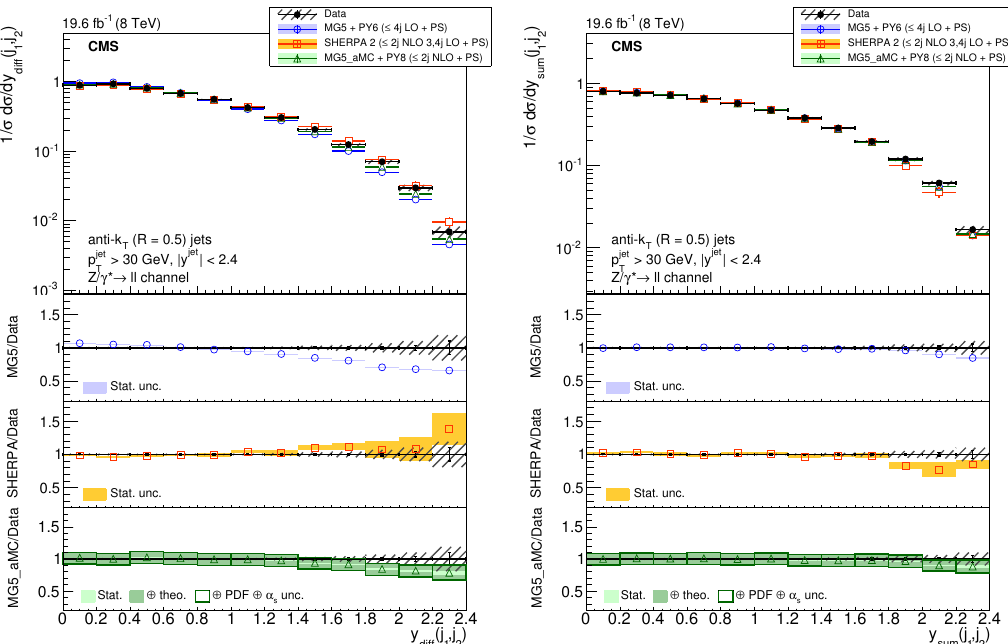
Figure 12 . The normalised di(cid:11)erential cross section for Z ( ! ‘‘ ) + jets ( N jets (cid:21) 2) production measured as a function of the (left) y di(cid:11) and (right) y sum of the two leading jets. The measurement is compared to the predictions calculated with MadGraph 5 + pythia 6, sherpa 2, and mg5 a mc + pythia 8. The lower panels show the ratios of the theoretical predictions to the measurements. Error bars around the experimental points show the statistical uncertainty, while the cross-hatched bands indicate the statistical and systematic uncertainties added in quadrature. The boxes around the mg5 a mc + pythia 8 to measurement ratio represent the uncertainty on the prediction, in- cluding statistical, theoretical (from scale variations), and PDF uncertainties. The dark green area represents the statistical and theoretical uncertainties only, while the light green area represents the statistical uncertainty